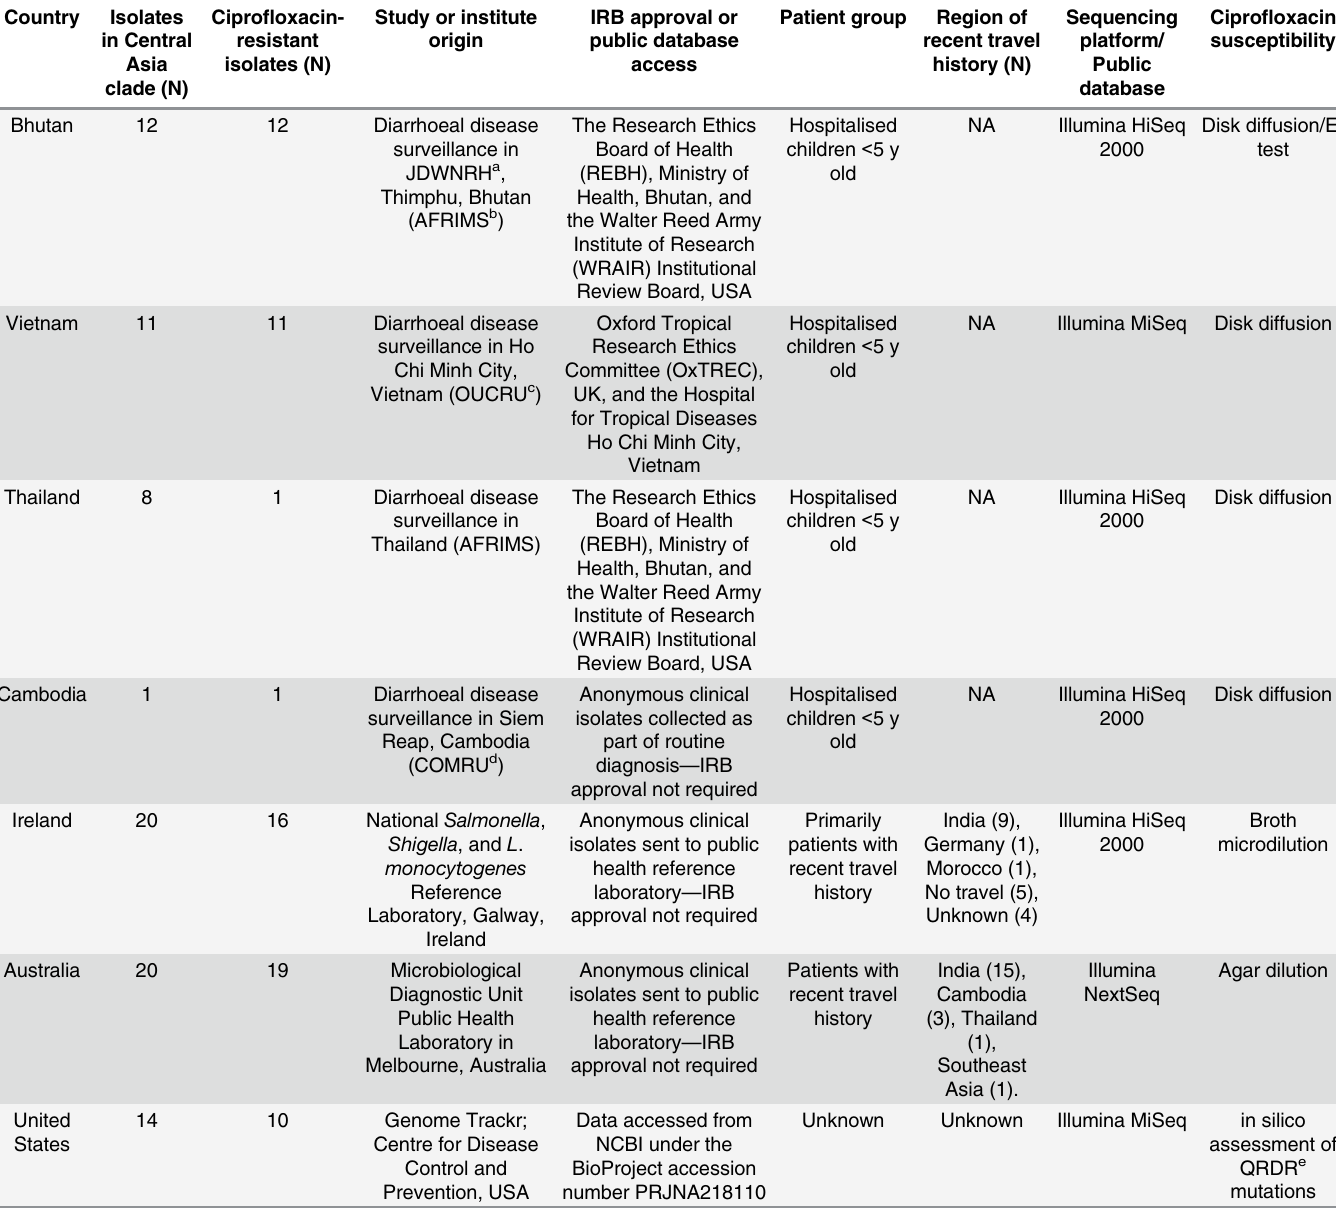
Table 1. The origins of the Shigella sonnei isolates and sequences used in this study.